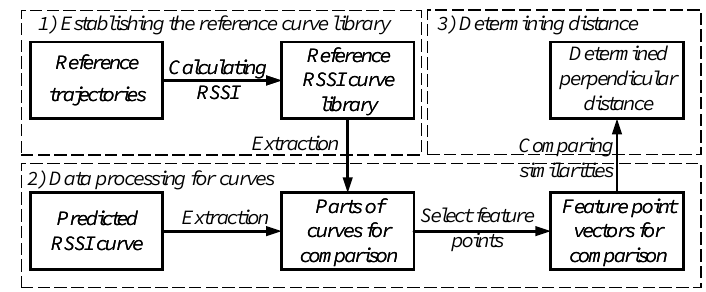
Figure 6. The process of determining the perpendicular distance from a node to the